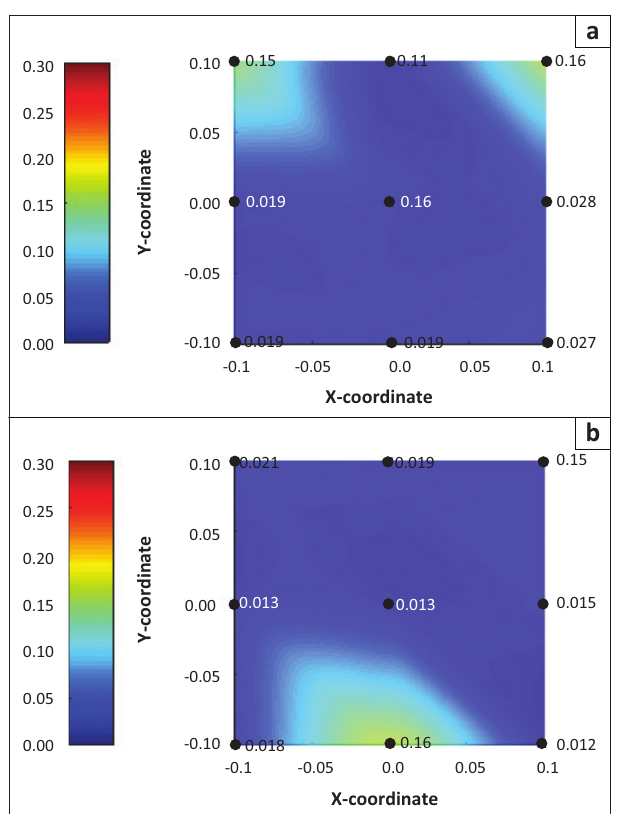
FIGURE 6: Pseudo-3D maps for standard deviations for oscillatory threshold for (a) test and (b) retest values at each of the nine points within the macular field test for the sample ( n = 26) of right eyes. (a) test and (b) retest.